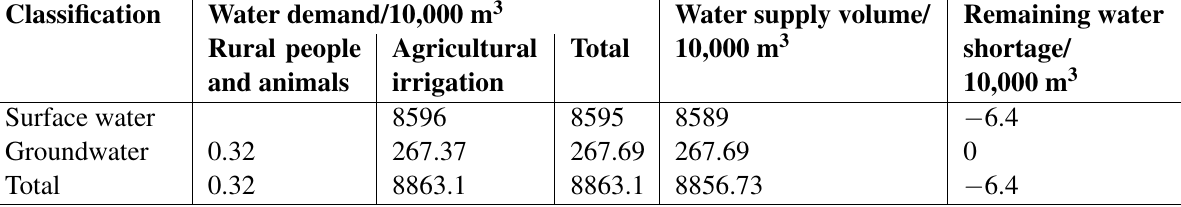
Table 1 Water resources balance analysis results for the planning level year (2020) of farmland irrigation